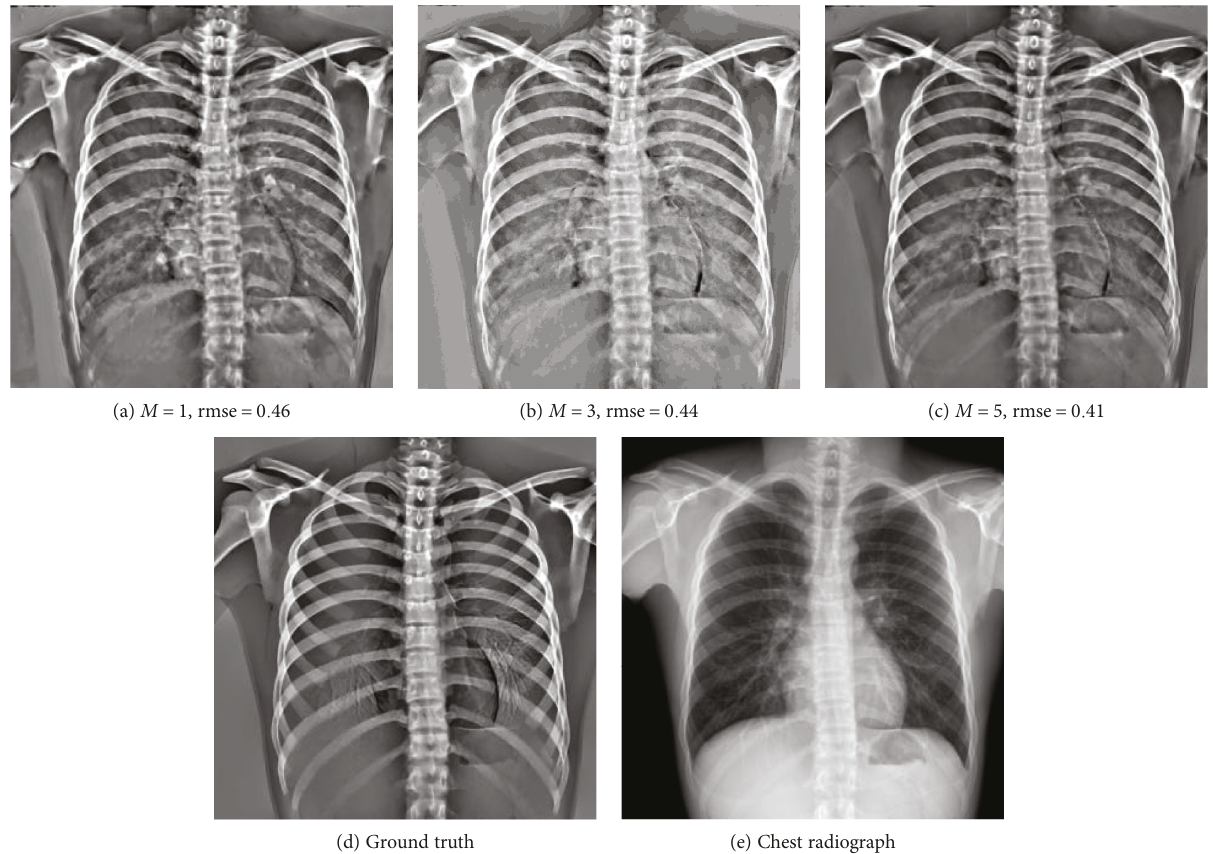
Figure 10: The reconstructed bone images using the di ff erent numbers of exemplars. From left to right, the numbers of used exemplars ( M ) are 1, 3, and 5, respectively. rmse is the root mean squared error of the reconstructed soft tissue image. (a – c) are the reconstructed bone images. (d) corresponds to the ground truth. The corresponding standard chest radiograph is shown in (e).